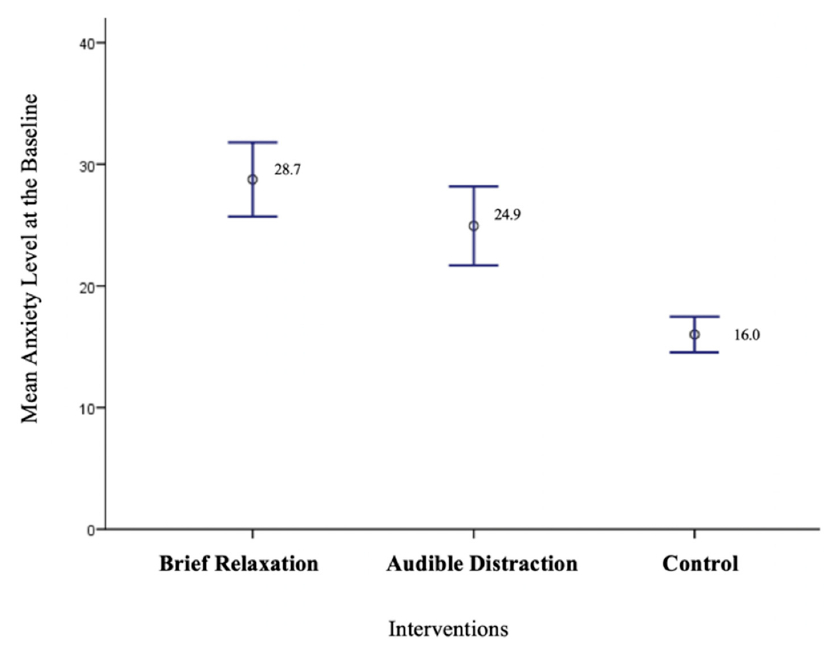
Figure 2. Mean Hierarchical Anxiety Questionnaire scores at the baseline. Table 1. Difference in the anxiety level between the three groups before and after the interven- tions.